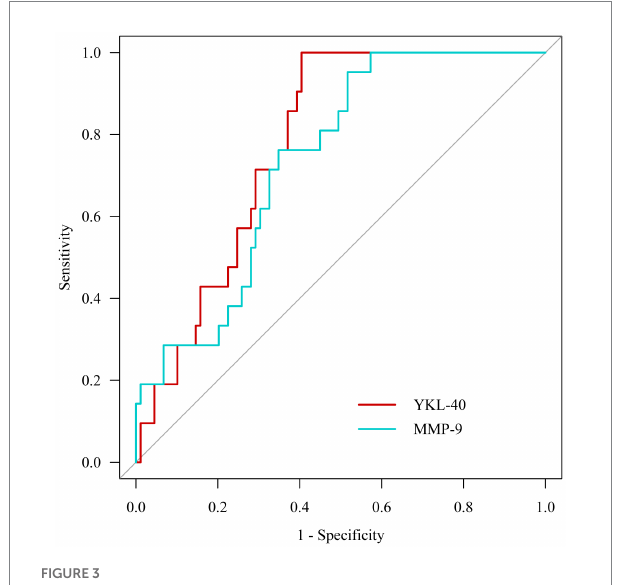
FIGURE 3 Receiver operating characteristic curve analysis.